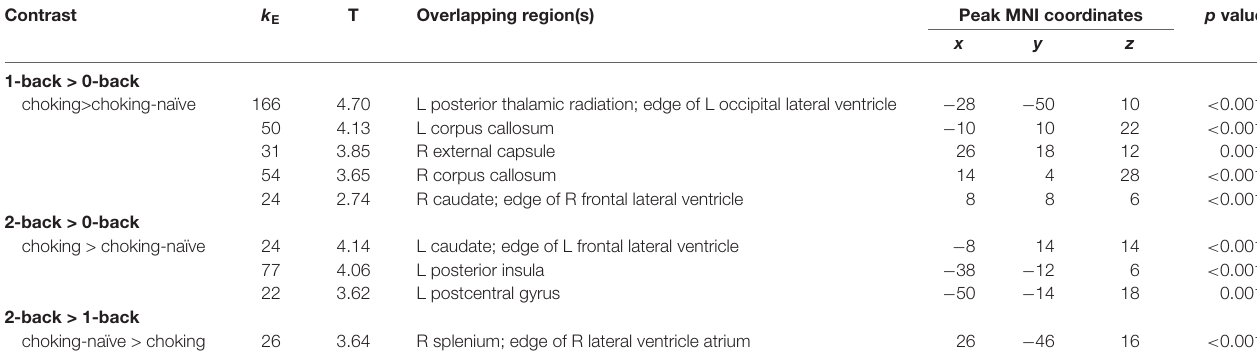
TABLE 2 | Activation details for significant activation clusters for group comparisons on verbal N-back working memory task. Contrast k E T Overlapping region(s) Peak MNI